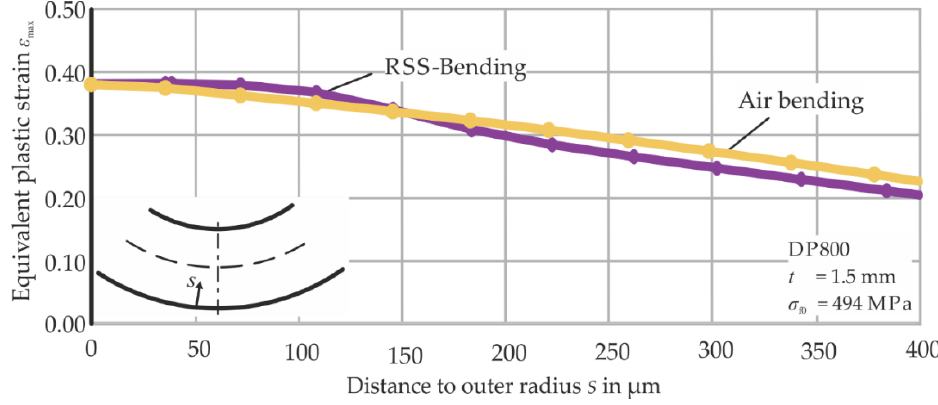
Figure 14. Equivalent strain distribution in air bending and RSS bending at the outer fiber.